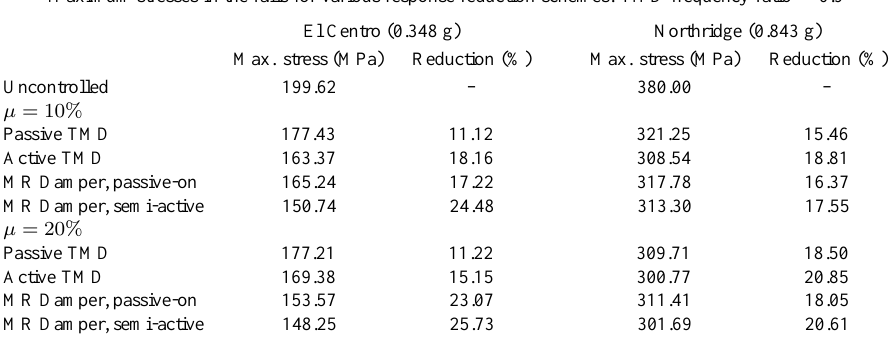
Table 1 Maximum stresses in the rails for various response reduction schemes. TMD frequency ratio =